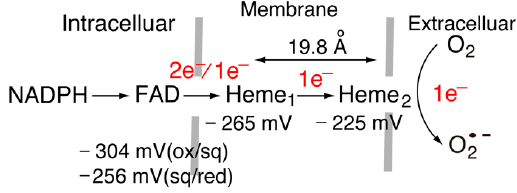
Figure 6. Membrane-bound NADPH-oxidase.